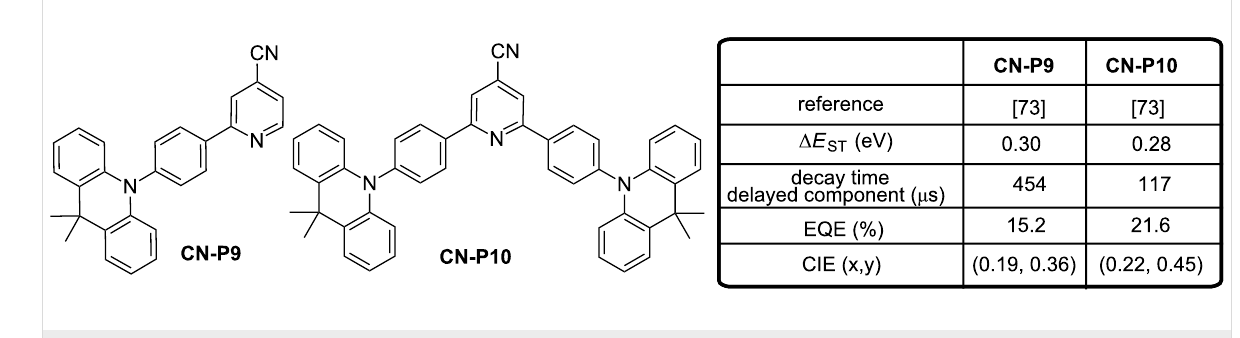
Figure 12: CN-Substituted pyridine derivatives CN-P9 and CN-P10